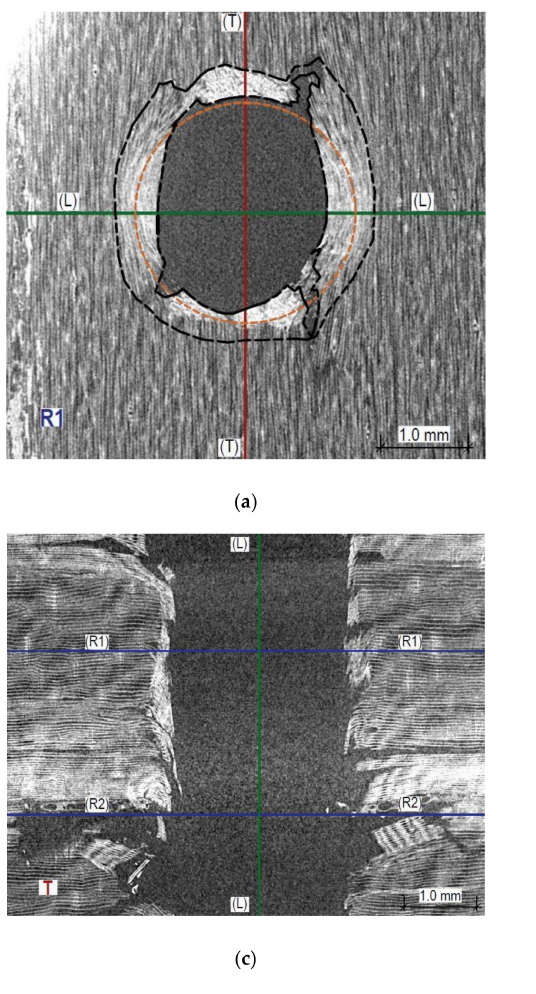
Figure 13. Sections through the opening resulting from the sclerometric test on the sample in the air-dry state: ( a ) Cross- section within earlywood R1—tangential section of wood is visible; ( b ) Cross-section within latewood R2—tangential section of wood is visible; ( c ) Longitudinal section T—radial wood section is visible; ( d ) Longitudinal section L—a cross-section of wood is